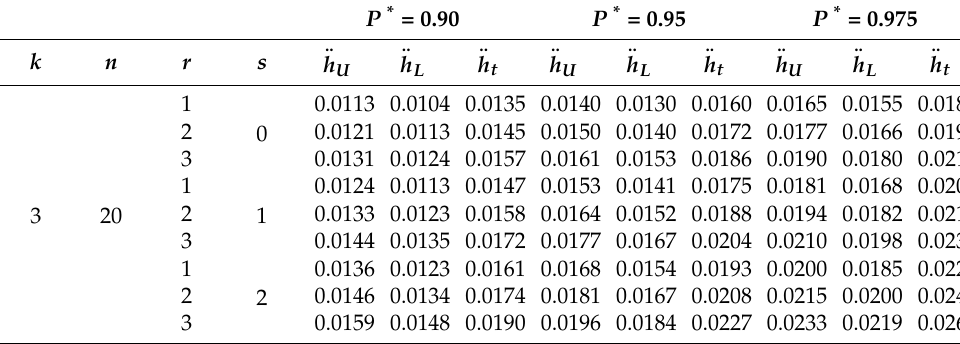
Table 1. Critical values